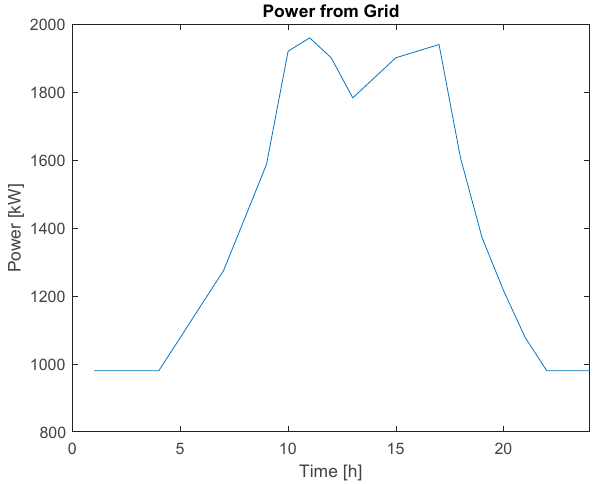
Figure 3. Power from grid for grid only case.